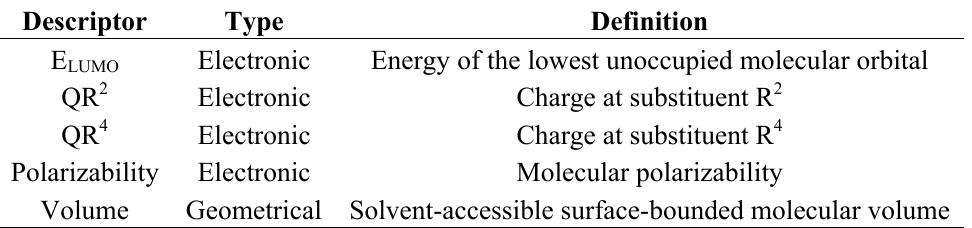
Table 1. Symbols, types and definitions of selected descriptors